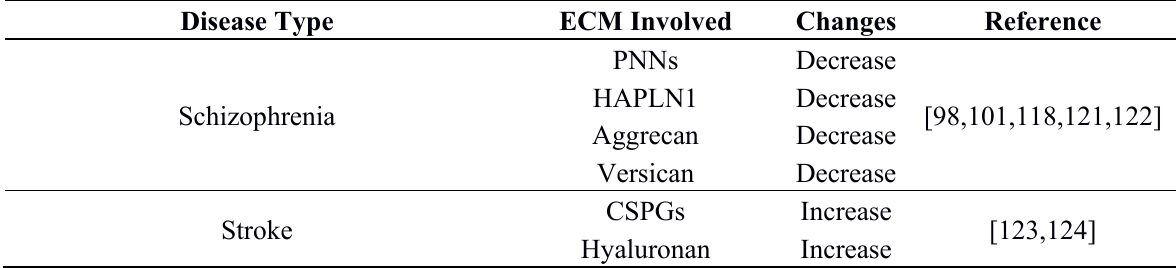
Table 1. A list of neurological diseases and their associated ECM